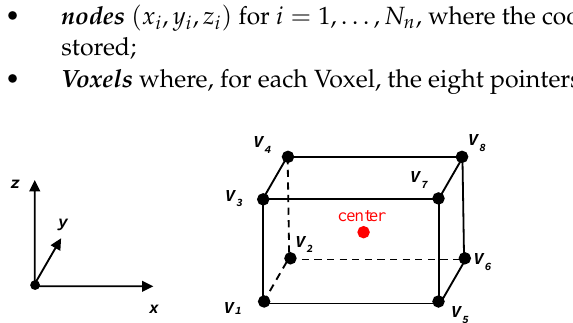
Figure 3. The scheme generation of the vertices of each